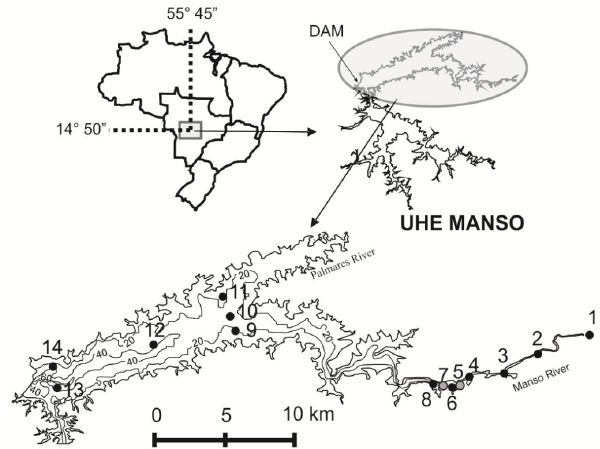
Figure 1: Study area and bathymetry of Manso reservoir with contours at 20-m intervals. The grey circles (temperature, fluorescence and photosynthetically available radiation [PAR]) and filled circles (temperature, conductivity, dissolved oxygen, fluorescence and photosynthetically available radiation PAR) mark the sampling and transect stations. Position 13 also indicates the location of the limnolo-meteorological station (SIMA), MAN-13. The locations of the thermistor chain and drifter deployments are indicated by position 8.